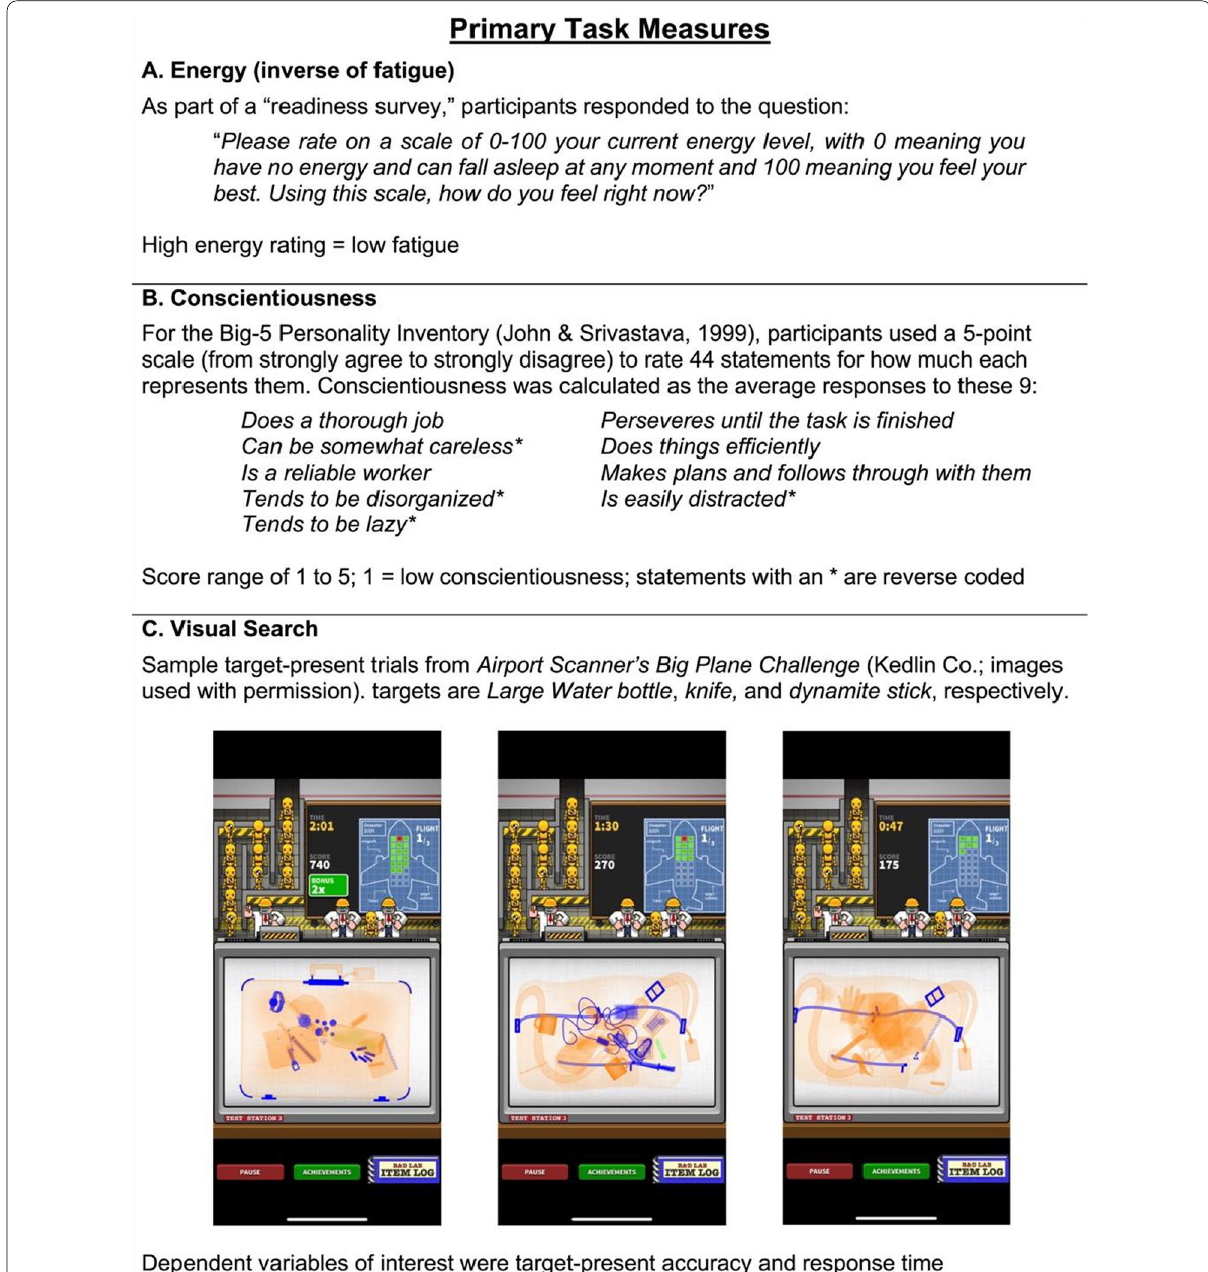
Fig. 1. Study measures of A energy (i.e., the inverse of fatigue), B conscientiousness, and C visual